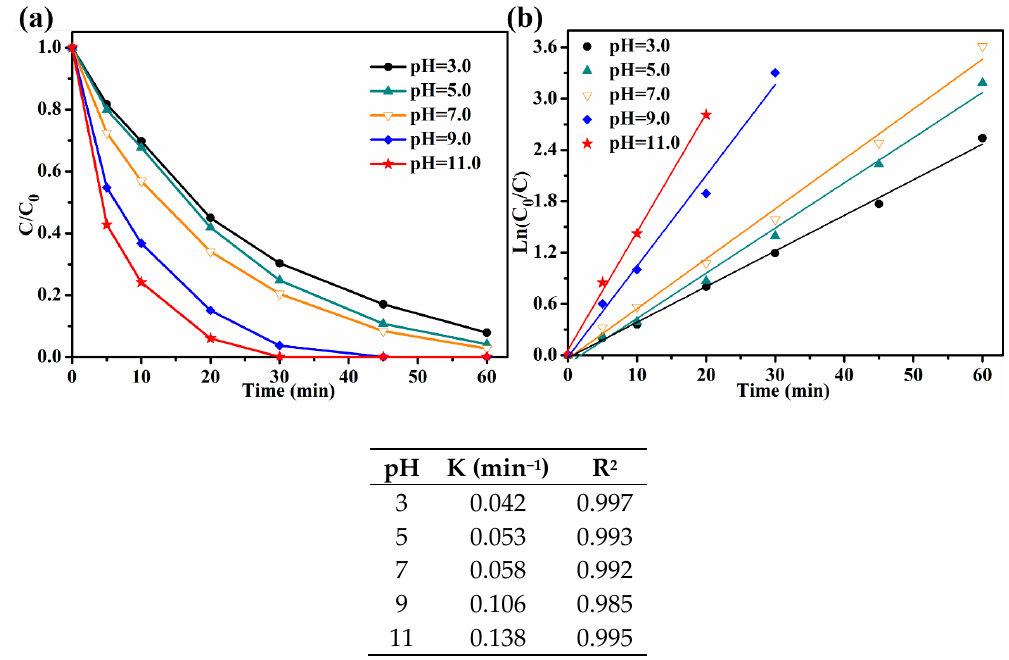
Figure 8. ( a ) Effect of pH on ATL degradation, ( b ) Pseudo- first-order model. The initial ATL concentration of 18.77 µM and mixed phase concentration of 2.0 g/L; temperature: 20 °C.